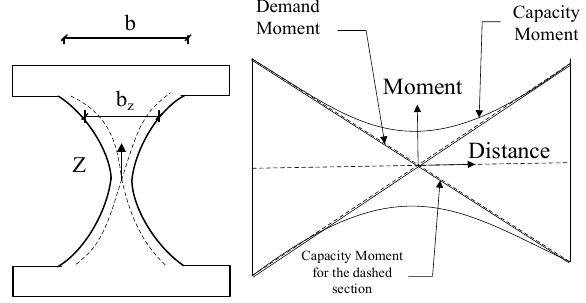
Figure 4. The damper geometry for uniform yielding design concept.